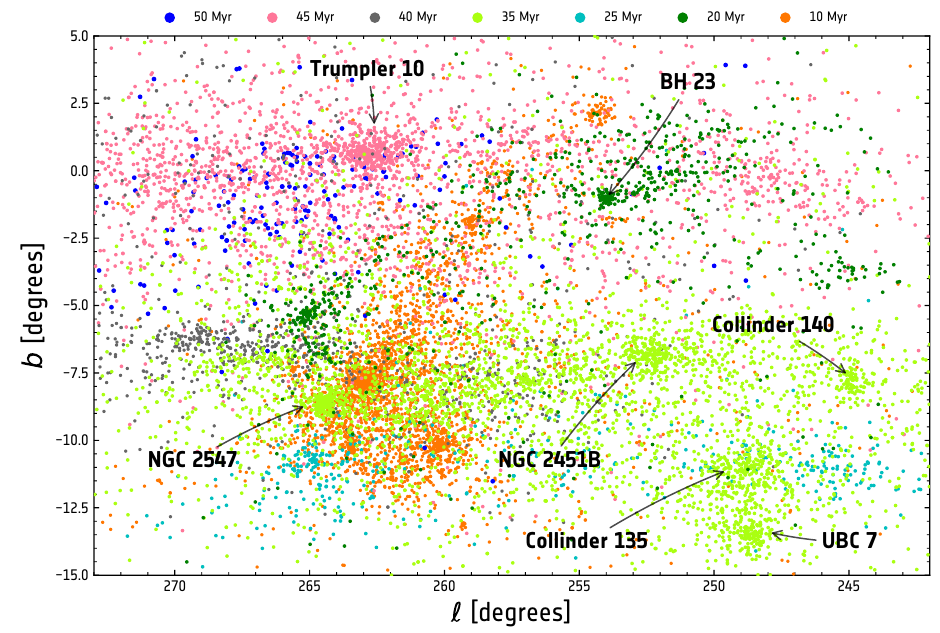
Figure 5. Distribution of young stars in the Vela–Puppis complex. The main groups known prior to Gaia are labelled. Adapted from Cantat-Gaudin et al.